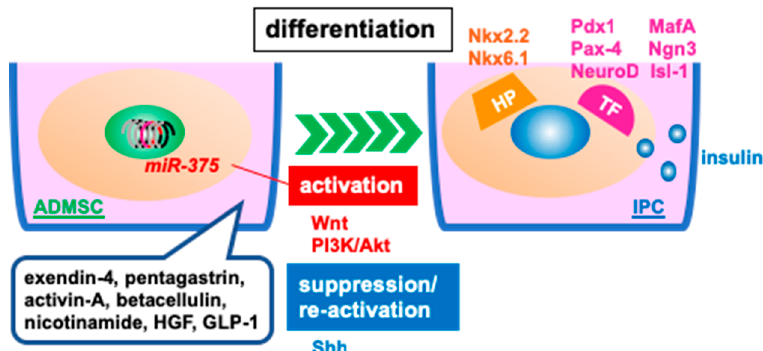
Figure 2. Differentiated insulin-producing cells (IPCs) for transplantation. Adipose tissue-derived mesenchymal stromal cells (ADMSCs) are differentiated into IPCs in the culture medium supplemented with exendin-4, pentagastrin, activin-A, betacellulin, nicotinamide, hepatocyte growth factor (HGF), and glucagon-like peptide-1 (GLP-1). Wnt and the phosphoinositide 3-kinase (PI3K) signaling pathway play a role in the activation of differentiation, whereas the sonic hedgehog (Shh) signaling pathway works in suppression and re-activation. MicroRNA-375 (miR-375) also promotes differentiation. The differentiated-IPCs express some homeobox proteins (HPs), including Nkx2.2 and Nkx6.1; and transcription factors (TFs), including Pdx-1, MafA, Pax-4, Ngn3, NeuroD and Isl-1.